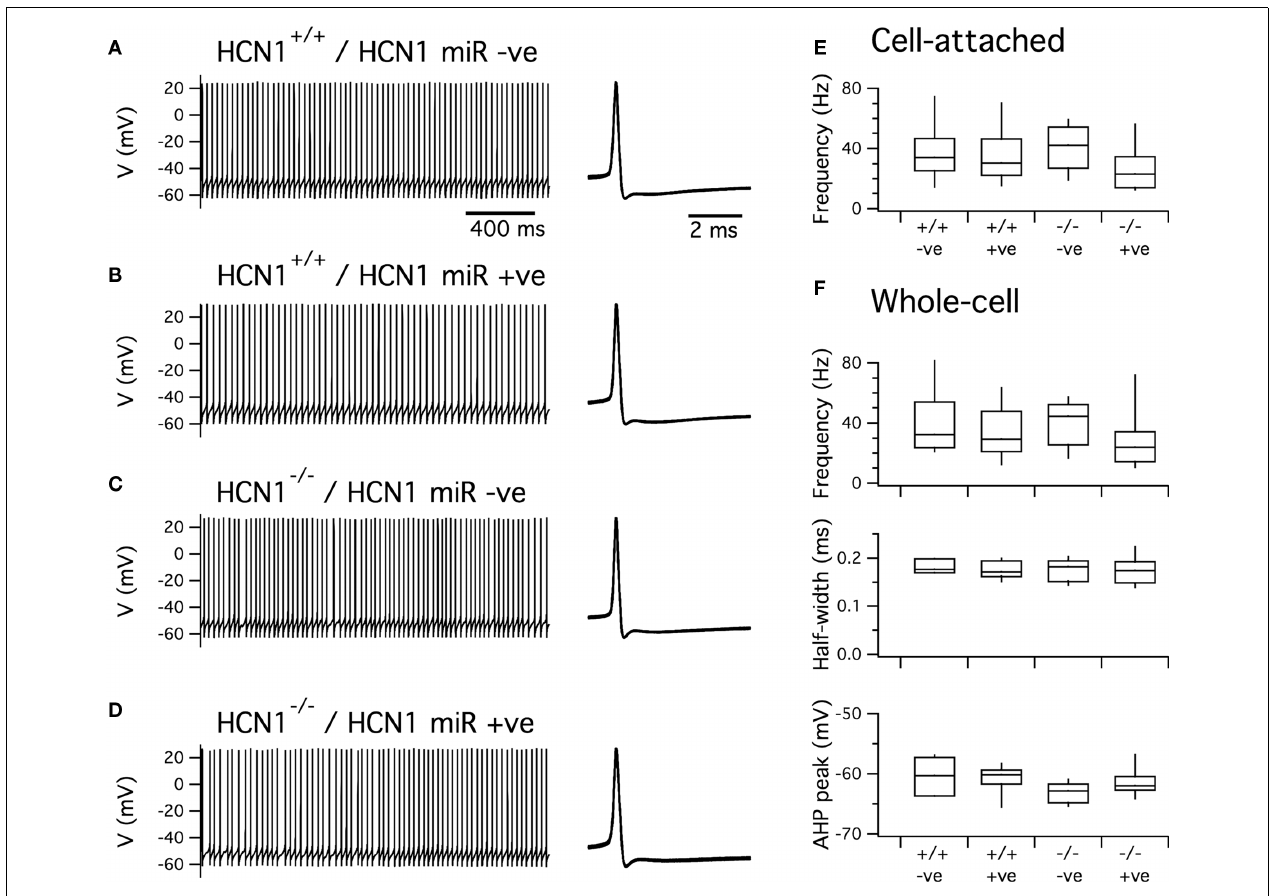
action potentials recorded from Purkinje cells in the current-clamp configuration.There was no significant effect of AAV on any parameter ( p > 0.14) and no significant effect of genotype on spike frequency or AHP duration.There was a significant effect of genotype on the AHP peak ( p = 0.034).This effect is small and is inconsistent with previous comparisons suggesting it may simply reflect a chance outcome expected from repeated statistical testing. Statistical analysis uses ANOVA. Group sizes were as follows: HCN1 + / + , HCN1 miR –ve ( n = 7 cells, 3 mice); HCN1 + / + , HCN1 miR + ve ( n = 9 cells, 3 mice); HCN1 + / + , HCN1 miR –ve ( n = 9 cells, 3 mice); HCN1 − / − , HCN1 miR + ve ( n = 9 cells, 3